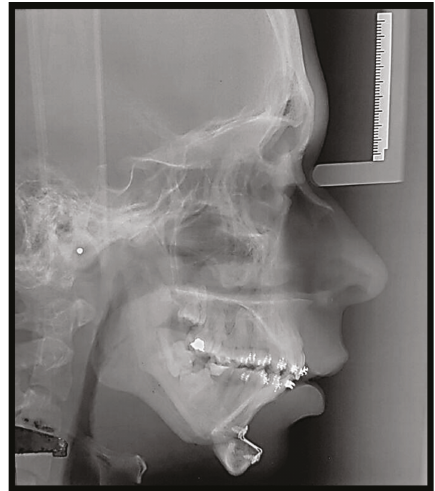
Figure 13: Pro fi le teleradiograph after seven days showing a better facial pro fi le with chin advancement.